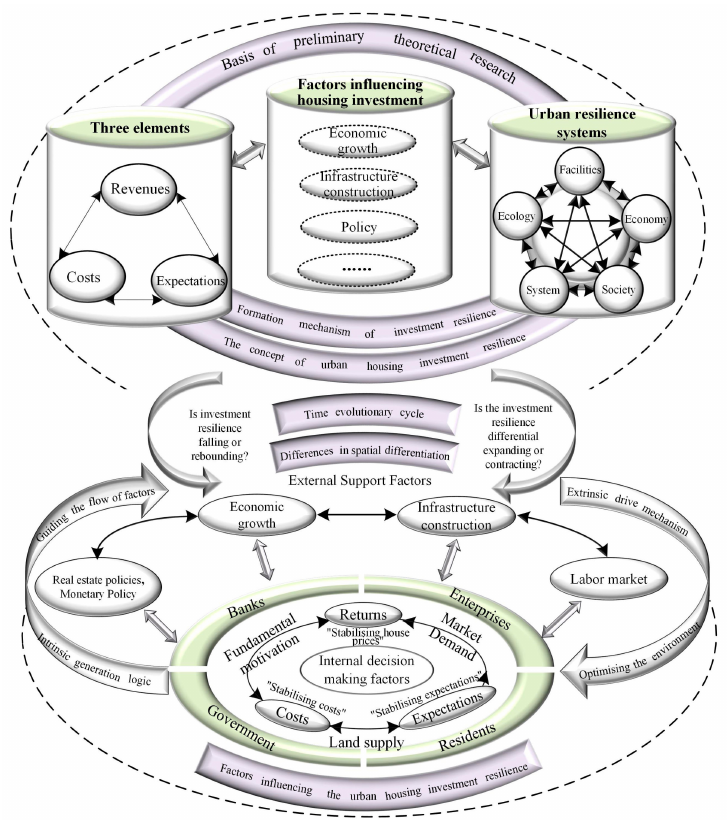
Figure 2. Research framework on urban housing investment resilience and its influencing